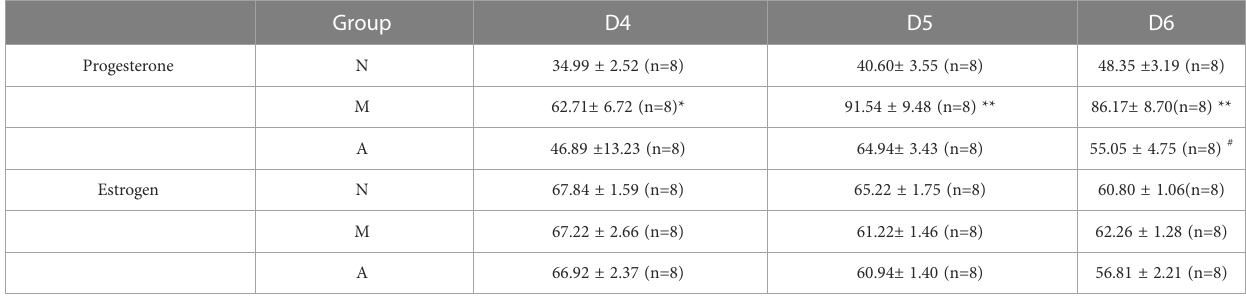
TABLE 3 The expression of serum progesterone and estrogen levels.